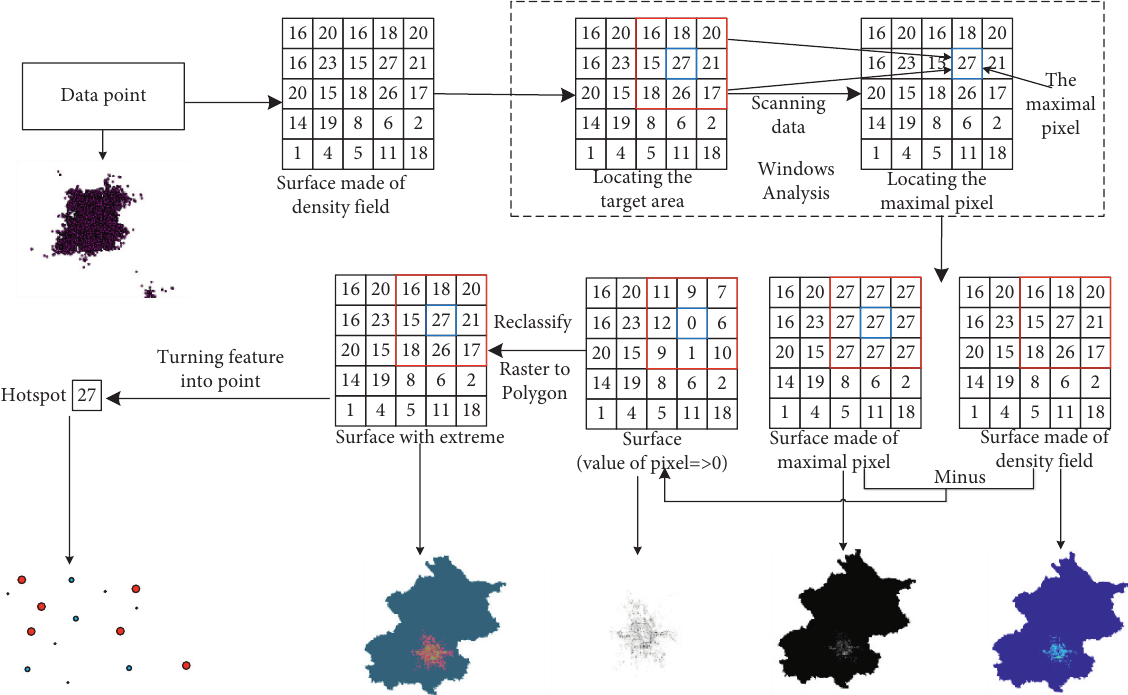
Figure 3: Principle demonstration of hotspot